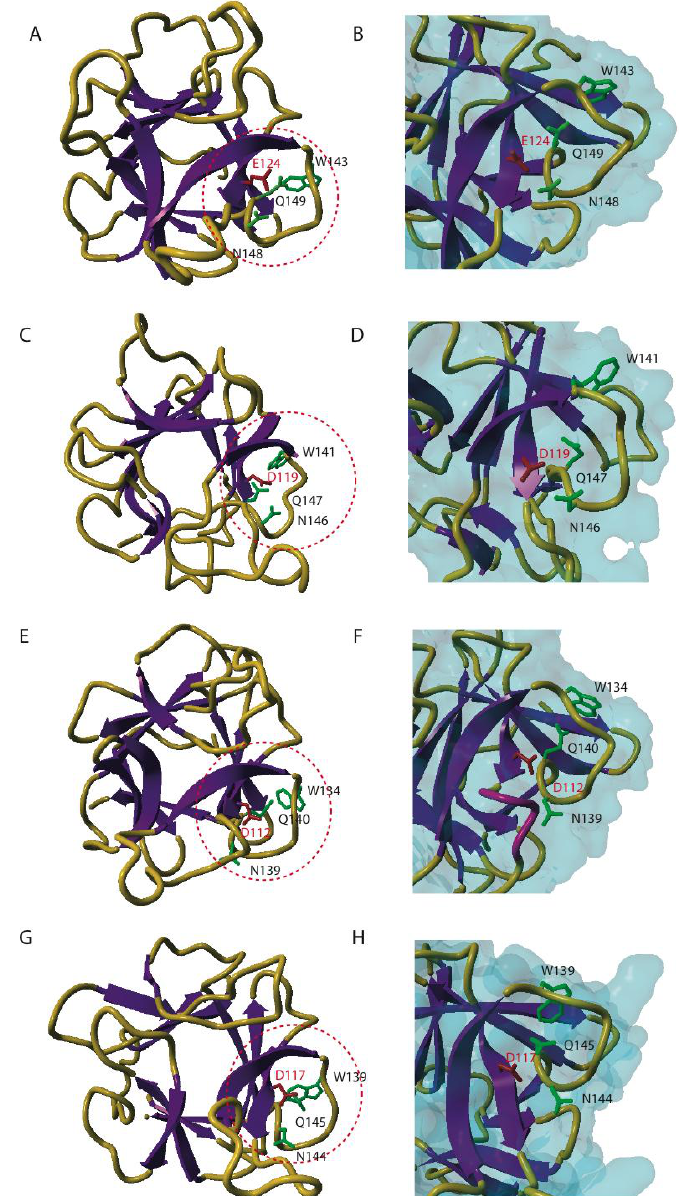
Figure 4. Three-dimensional models for different EUL domains. Ribbon diagrams of EEA (A) ArathEULS3 (C), OrysaEULS2 (E) and PhypaEULS3 (G) are shown. The strands of ß-sheet and the loops and coil regions are colored purple and orange yellow, respectively. The amino acid residues predicted to form the carbohydrate-binding site in a loop located at the C -terminal end of the polypeptide chain (red circle) are represented in green (W, N and Q residues) and red (E and D residues) sticks and labeled (according to the sequence). Panels B, D, F and H show an enlarged view of the carbohydrate-binding sites on the surface of EEA (B), ArathEULS3 (D), OrysaEULS2 (F) and PhypaEULS3 (H). The four amino acid residues forming the carbohydrate-binding sites are represented in sticks and labeled. The loop masking Asn139 residue in OrysaEULS2 is colored